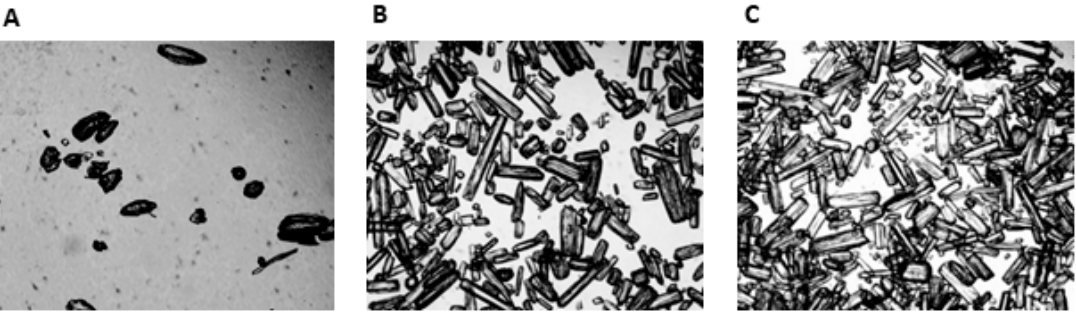
Figure 3. Microscopic illustration (40×) of the LOW ( A ), MED ( B ) and HIGH ( C ) L -Glutamine